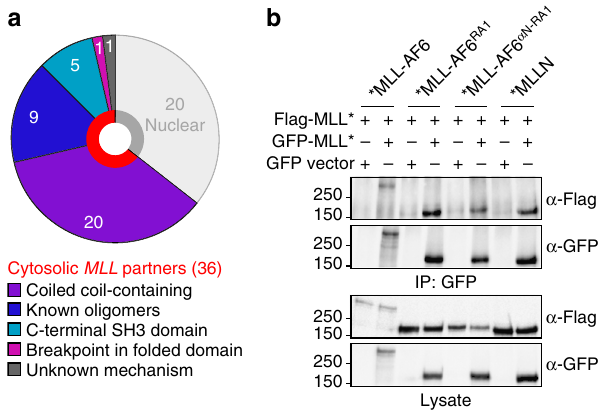
Fig. 7 Dimerization potential of cytoplasmic MLL fusion proteins and the in vivo oligomerization of MLL. a 34 of 36 cytoplasmic partners in the MLL recombinome are known to dimerize, are predicted to have coiled coils, or have potentially dimerizing C-terminal SH3 domains. In addition, 20 of the partners are nuclear, one has no appreciated dimerization capacity, and another truncates a dimerization domain. b Co-precipitation of differentially tagged MLL proteins. FLAG- and GFP-tagged MLL-AF6, MLL-RA1, MLL- α N/ RA1 or MLLN alone were co-expressed in HEK 293T